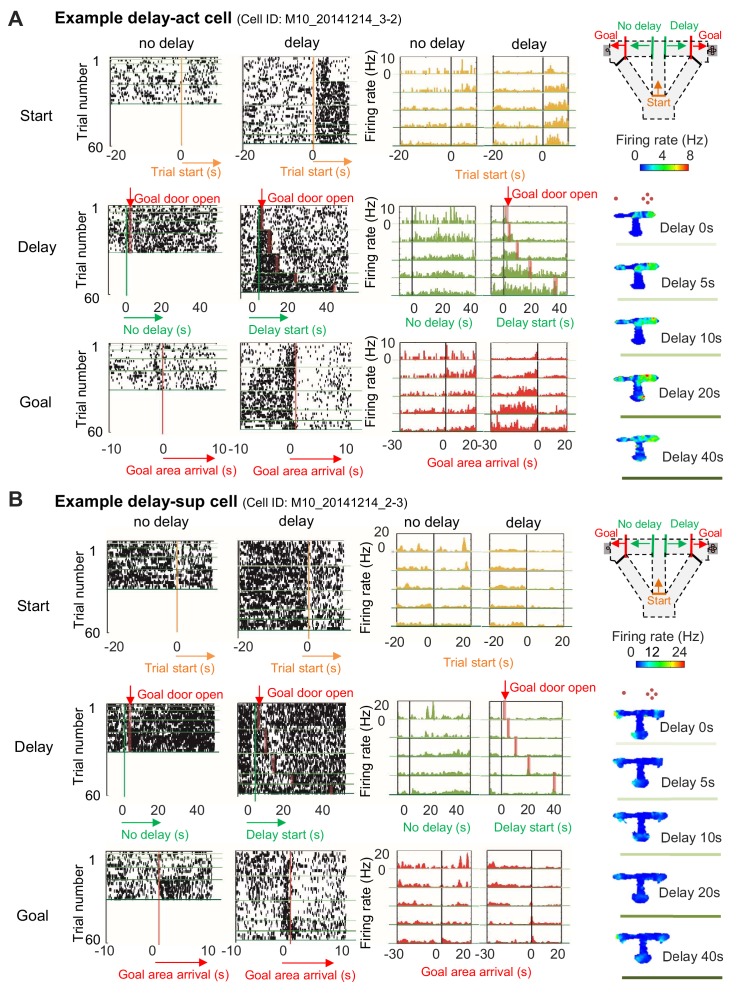
Increased or decreased neuronal activity of CA1 cells during delay.(A) An example of CA1 delay-active (delay-act) cells, which showed an increment in the firing rate as a function of delay length. Left, raster plots of the firing activity of the cells aligned with start-onset (top), delay-onset (middle) and goal-onset (bottom). Orange lines indicate start-onset. Green lines indicate delay-onset. Pale red lines indicate expected delay-offset. Red lines indicate goal-onset. Center, peristimulus time histograms (PSTHs) of the firing activity of the cells aligned with start-onset (top), delay-onset (middle) and goal-onset (bottom). Right, color-coded rate maps. The delayed arm was assigned to the right side with a large reward for this recording session. Red dots indicate the number of sugar pellets. (B) An example of CA1 delay-suppressed cells, which showed a decrement in the firing rate during delay. The delayed arm was assigned to the right side with a large reward for this recording session.